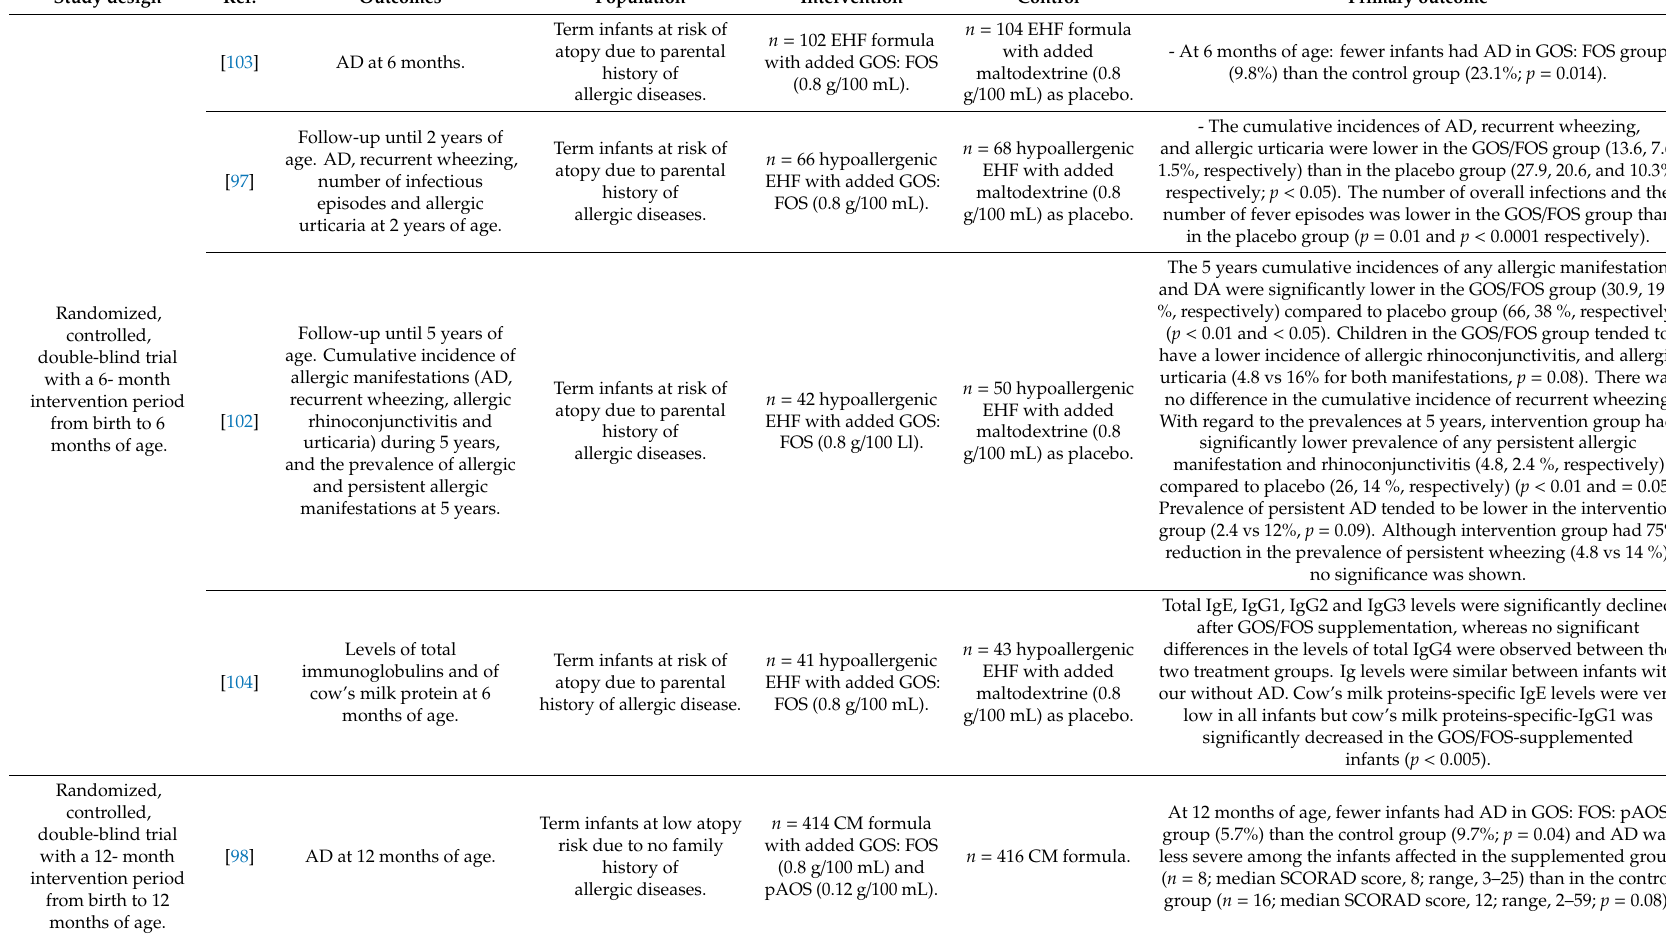
Table 3. Prebiotic supplementation of infant formula trials with allergic disease